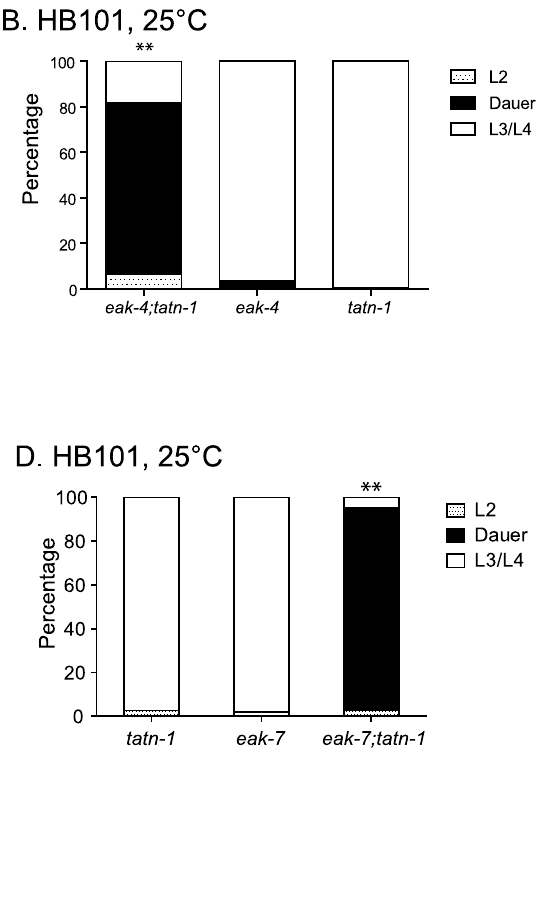
had little effect on dauer formation by the eak-4(mg348); tatn- 1(baf1) mutants (70% with pdk-1(mg142) versus 75% without) (Figure 4B). We further found that akt-1(mg144) had at most a